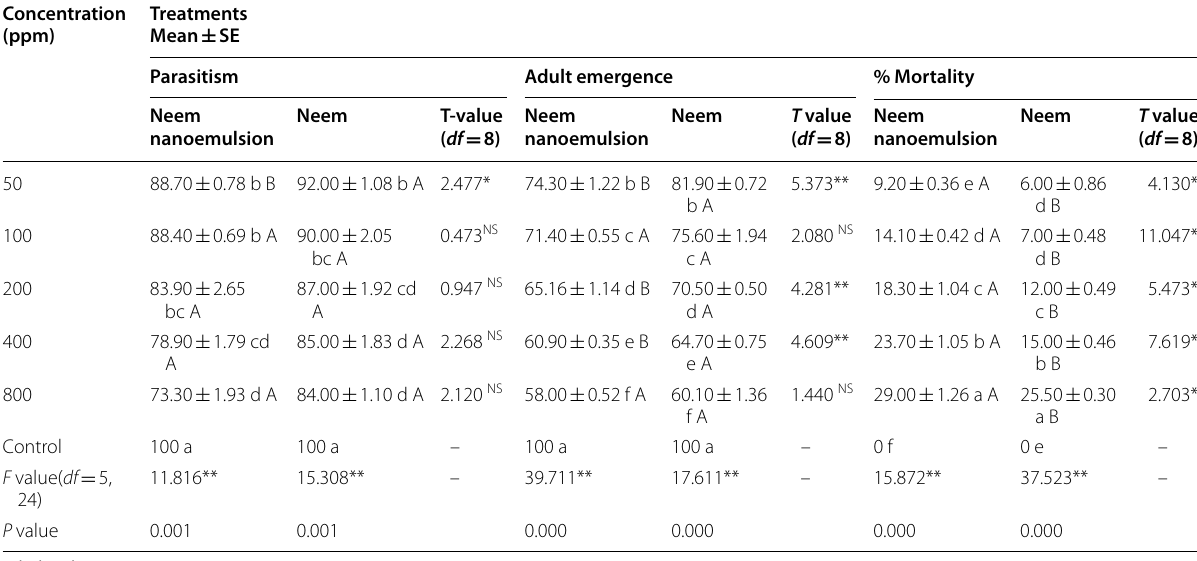
Table 2 Effect of neem oil and neem nanoemulsion on the parasitism, adult emergence, and mortality of the internal parasitoid larvae of Meteorus